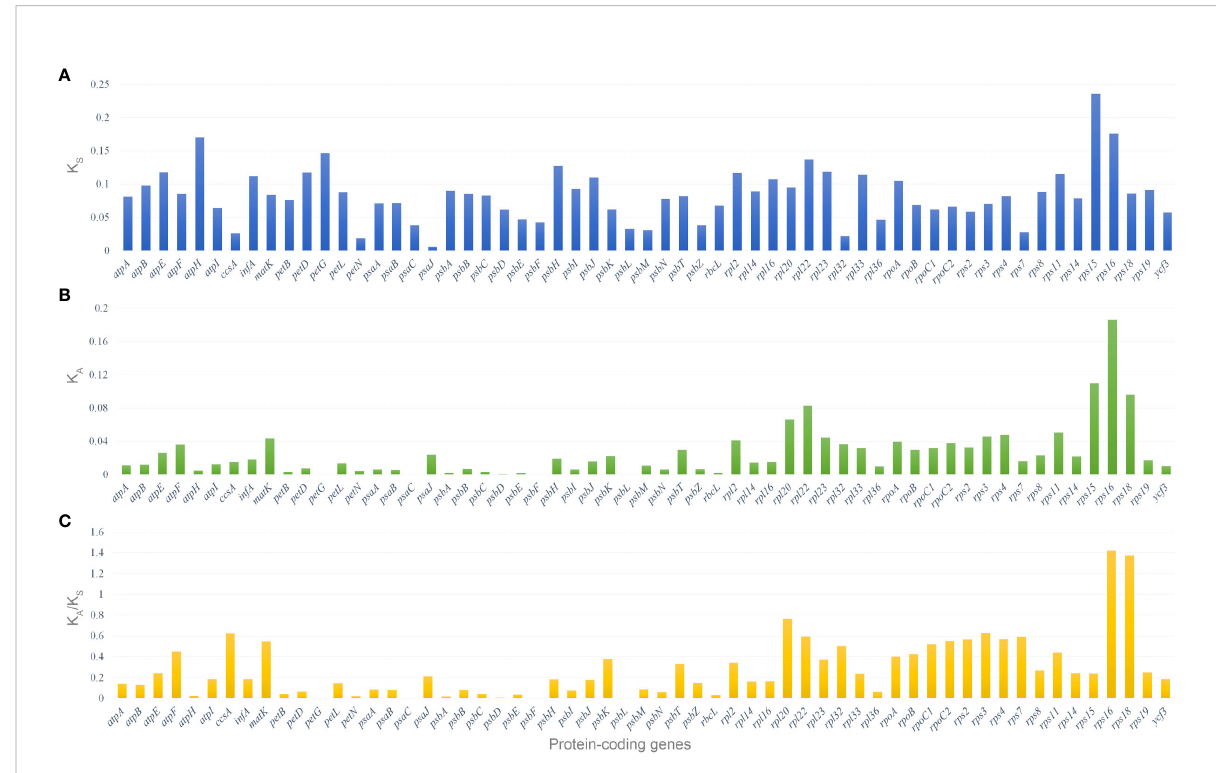
FIGURE 8 Selective pressure of 59 protein-coding genes in the 21 Corydalis plastomes. (A) K S , rate of synonymous substitution; (B) K A , rate of non- synonymous substitution; (C) K A /K S , rate of non-synonymous vs. synonymous